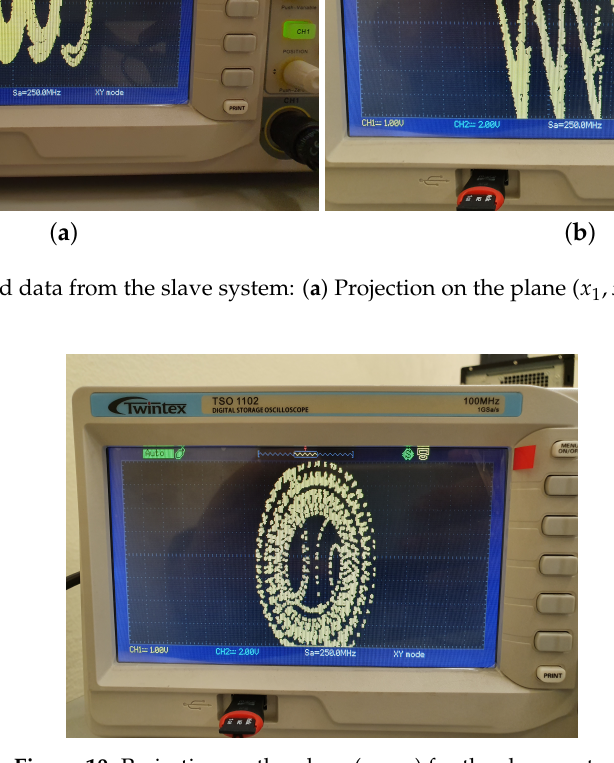
Figure 10. Projection on the plane ( x 1 , x 2 ) for the slave